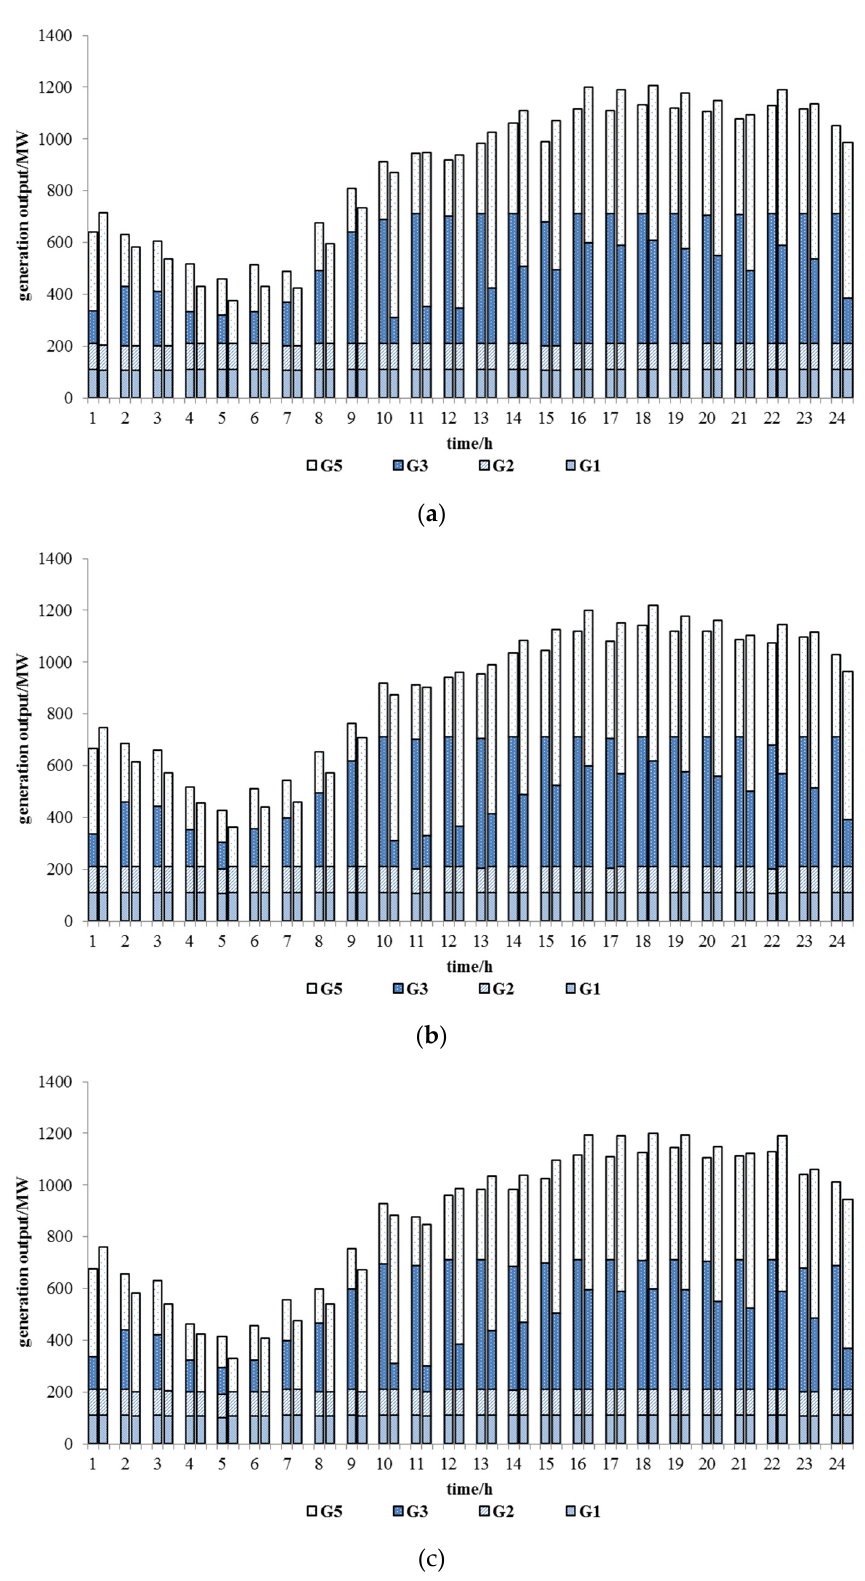
Figure 9. Generation output of scenario1 without transmission constraint. The generation output of G3 increases and G5 decreases when the transmission constraint is considered. Meanwhile, G3 has to start earlier such that it can achieve significantly high output level during the peak time. ( a ) Generation output in scenario 1; ( b ) Generation output in scenario 2; ( c ) Generation output in scenario 3.